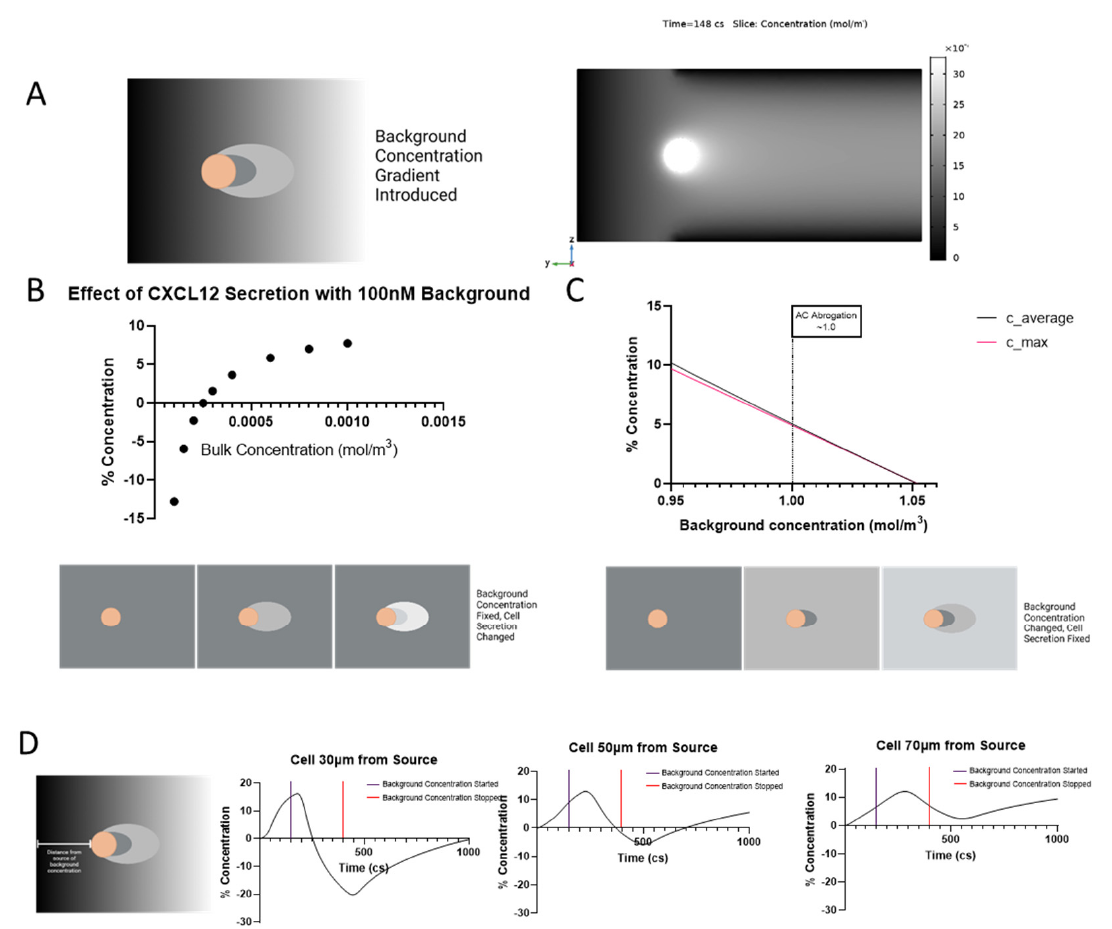
Figure 4. Background concentration reduces the concentration gradient around single cell. ( A ) Schematic of background concentration around a secreting cell (left) and timelapse video of background concentration added at 150 cs (right). Note that timelapse images are not to the same scale in order to better show background concentration. ( B ) Modulating cellular secretion rate of CXCL12 while keeping a constant background CXCL12 concentration of 100 nM. ( C ) Amount of background bound CXCL12 needed to decrease the cellular gradient below 5%. ( D ) Impact of distance between cell and source of CXCL12 background on gradient formation.